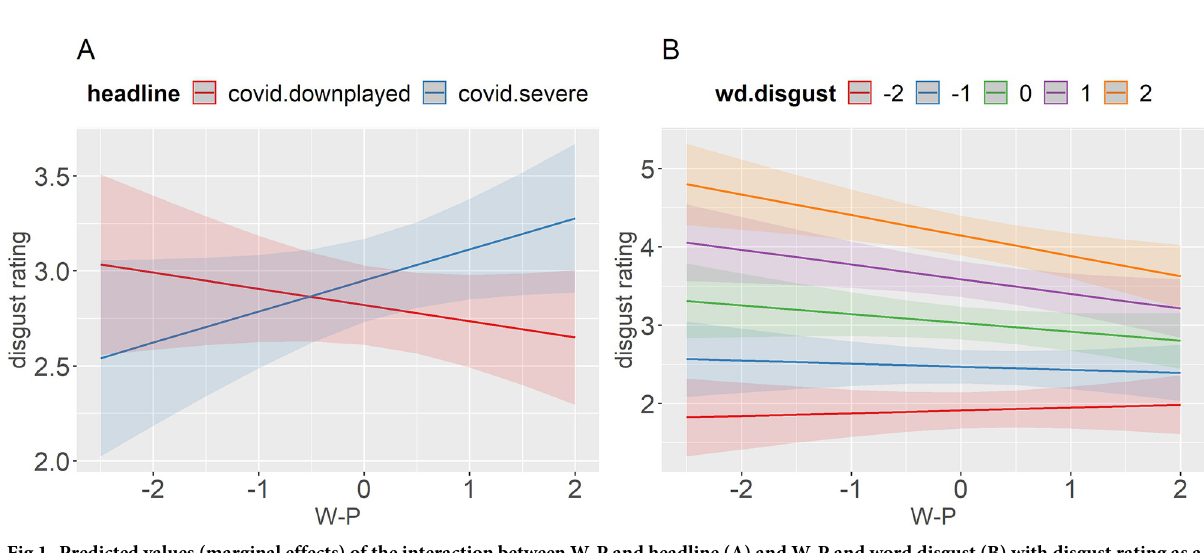
Fig 1. Predicted values (marginal effects) of the interaction between W-P and headline (A) and W-P and word disgust (B) with disgust rating as a dependent variable.